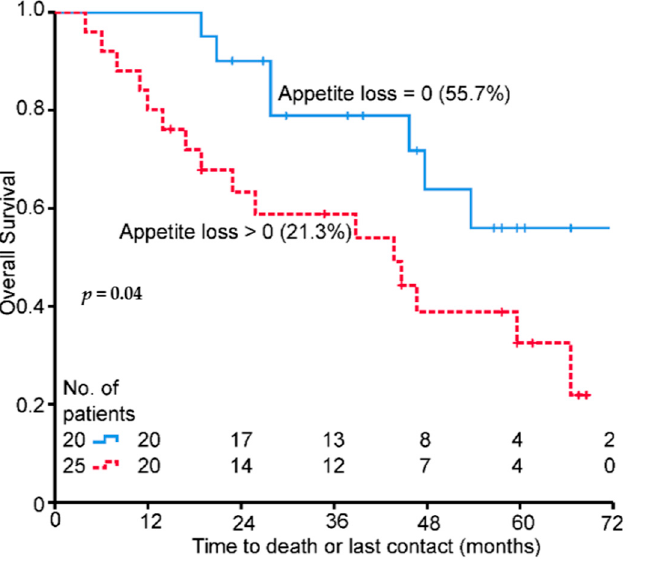
Figure 3. Baseline score Kaplan–Meier plots for overall survival and appetite loss, M1 patients only, 72-month OS% in brackets. Table 3. Overall survival of age-adjusted hazard ratios for M1 patients baseline and change scores QLQ C30 and QLQ CR38.